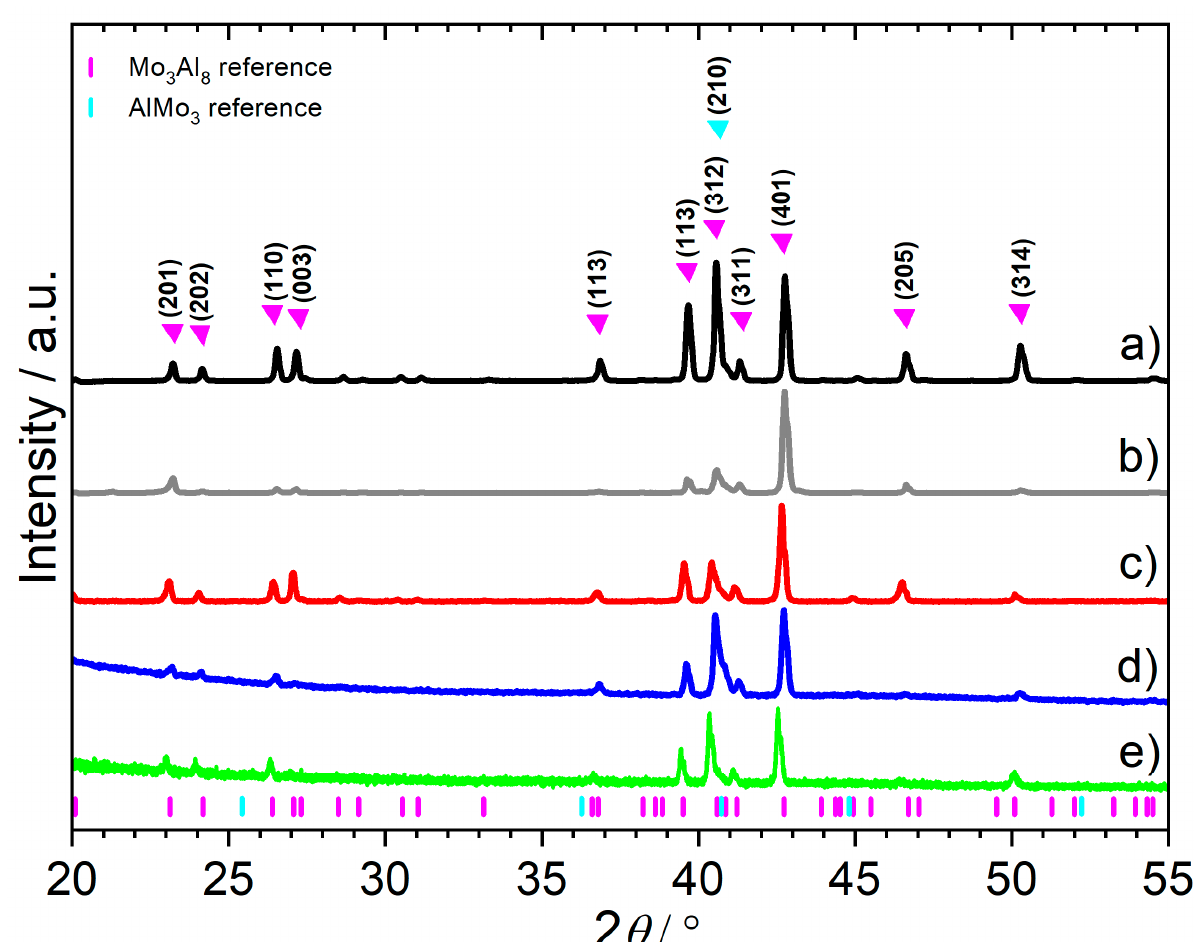
Figure 2. X-ray diffraction (XRD) pattern of ( a ) the wheel-side of the as-quenched ribbon; ( b ) the air-side of the as-quenched ribbon; ( c ) the air side of the sample obtained by single-step free corrosion in 1 M KOH at room temperature for 6 h (denoted as SS_KOH); ( d ) wheel side of the sample obtained by single-step free corrosion in 1 M HF at room temperature for 24 h (denoted as SS_HF) and; ( e ) wheel side of the sample obtained by double-step free corrosion first in 1.25 M FeCl 3 for 1 h and then in 1 M HF for 6 h both at room temperature (denoted as DS_1h).